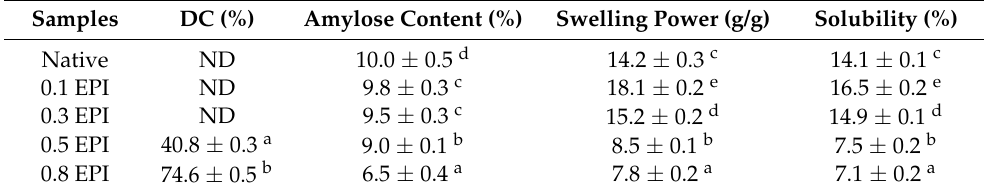
Table 1. Degree of cross-linking and physicochemical properties of native and modified starches.